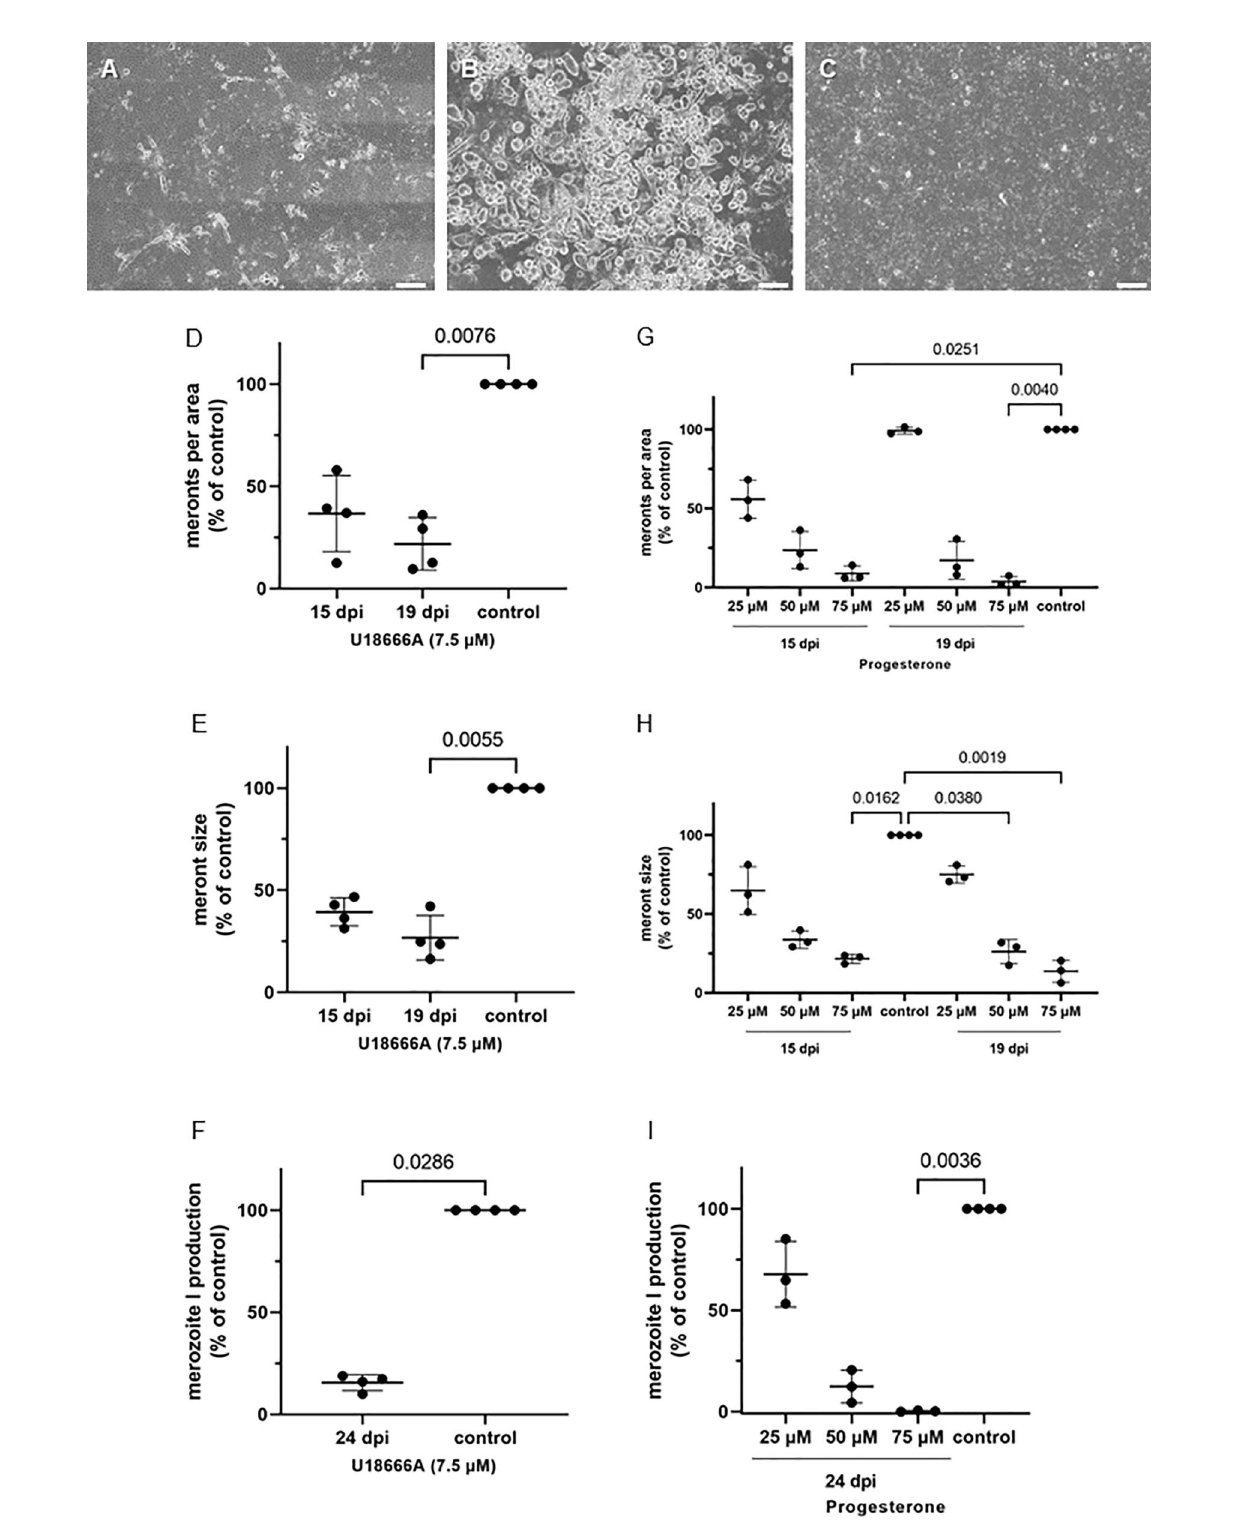
FIGURE 8 | U18666A and progesterone treatments block E. bovis replication. (A) U18666A treated-, (B) control- and (C) progesterone treated- E. bovis-infected BUVEC (3-4 biological replicates with technical duplicates) at 19 d p. i. Number of meronts I (D, G) and meront I size (E, H) were calculated at 15 and 19 d p. i., and merozoite I production (F, I) was determined at 24 d p. i. Results are expressed as percentage of untreated controls (100%). Scale bar 200